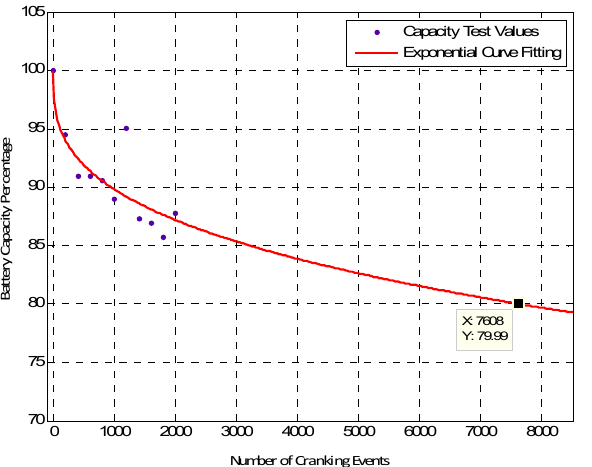
Figure 17. Battery alone capacity versus cranking events with exponential extrapolation.